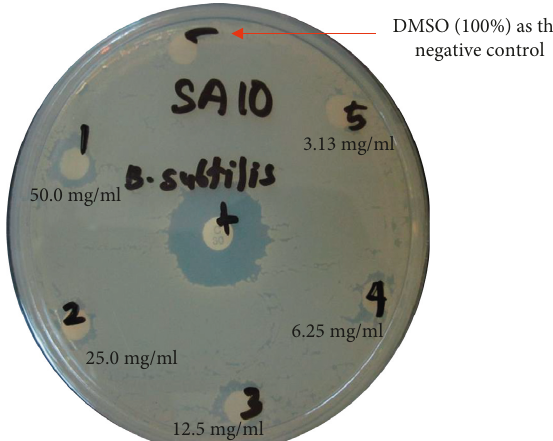
Figure 1: Antibacterial activity of compound 2b towards bacte- rium Bacillus subtilis